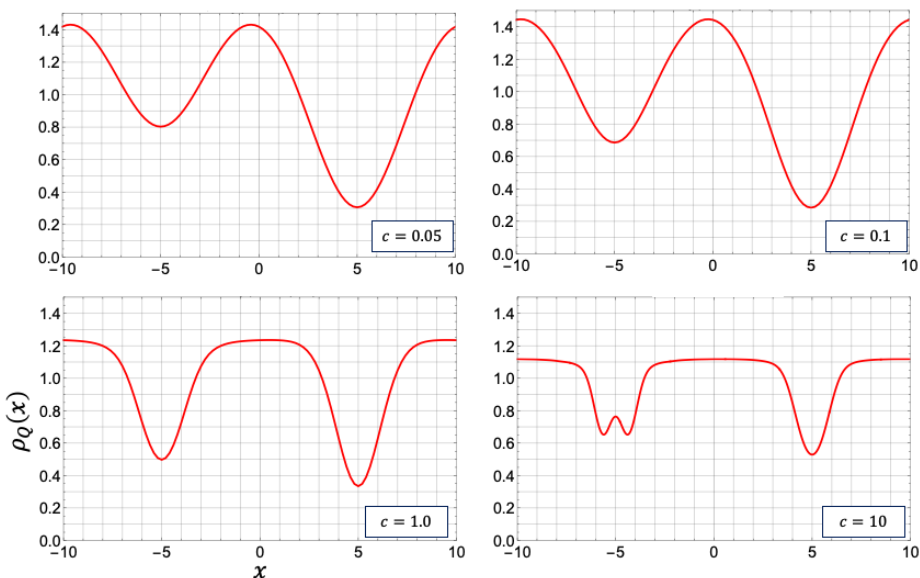
Figure 12. Density profiles ρ Q ( x ) for N = L = 20 and c = 0.05, 0.1, 1.0, and 10. The target soliton depths d for the Gaussian weights are given by 0.6 and 0, and the Gaussian parameters are given by ( P ) = ( 0.124027 π ,0.106667 ) and ( P (cid:48) , σ (cid:48) ) = ( π ,0.421637 ) , which are calculated by Equations (93) 0 , σ 0 and (94). The density profile is calculated in the same way as in Equation (86).